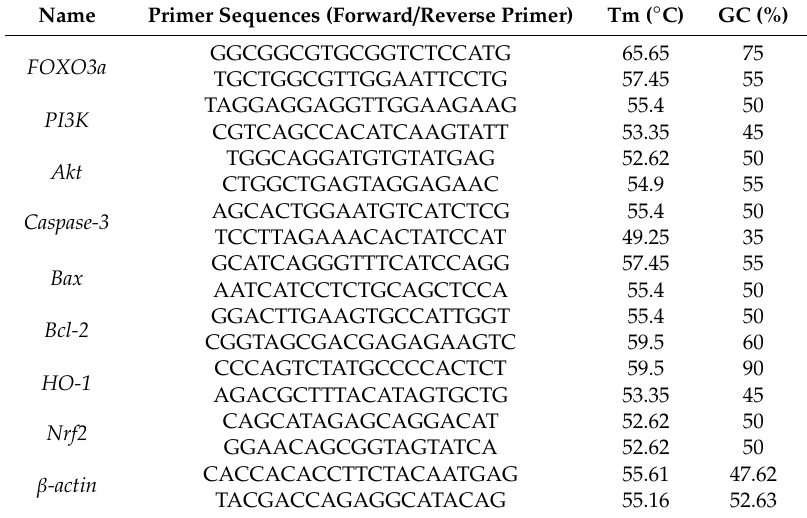
Table 2. Sequences used for